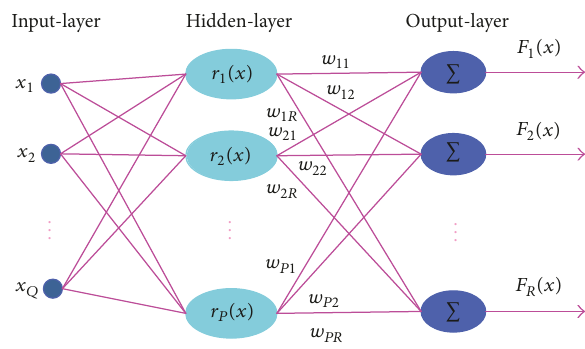
Figure 2: RBF NN